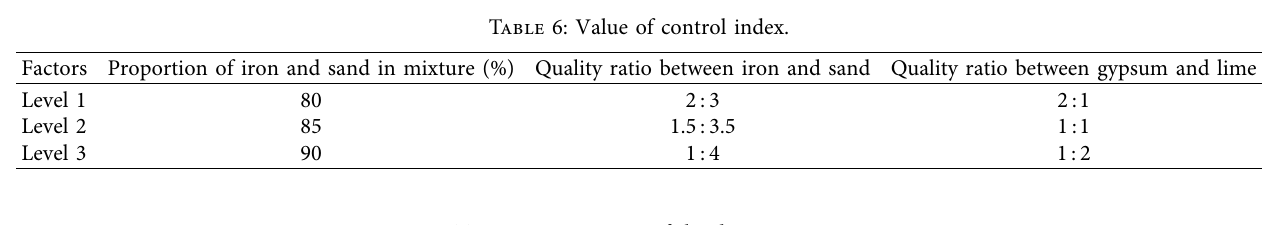
Table 7: Instrument of the density